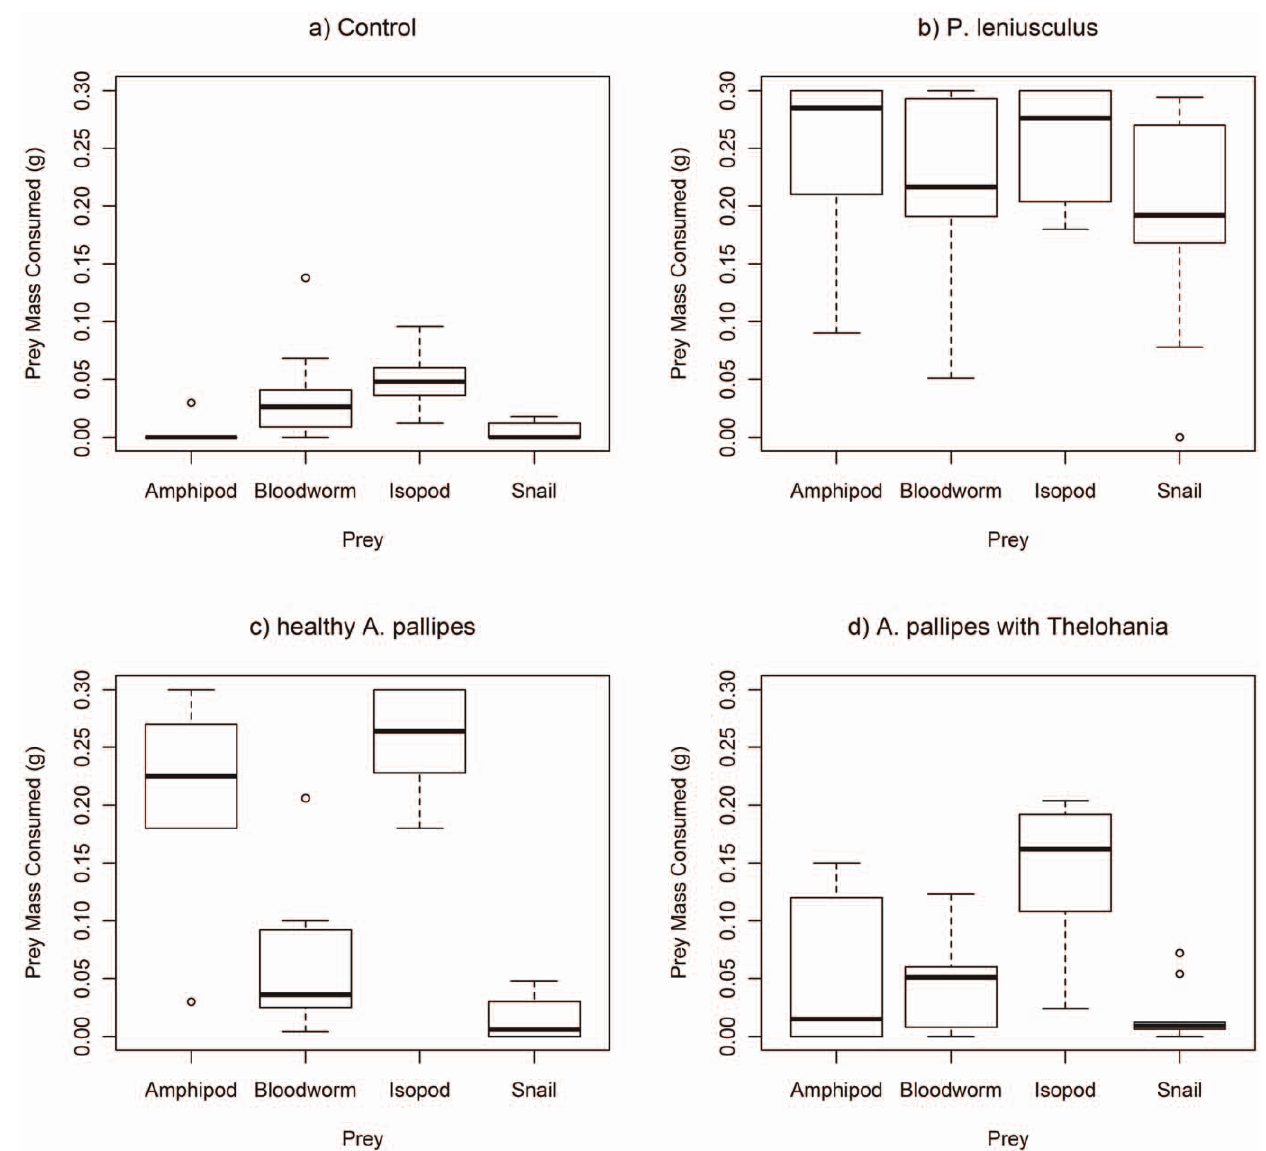
Figure 2. Prey consumption (g) by crayfish predators for mobile food items. Trials with P. leniusculus , healthy A. pallipes , A. pallipes with T. contejeani , and controls. Plots show medians (thick line), interquartile ranges (boxes) and data range (whiskers), with outliers as open